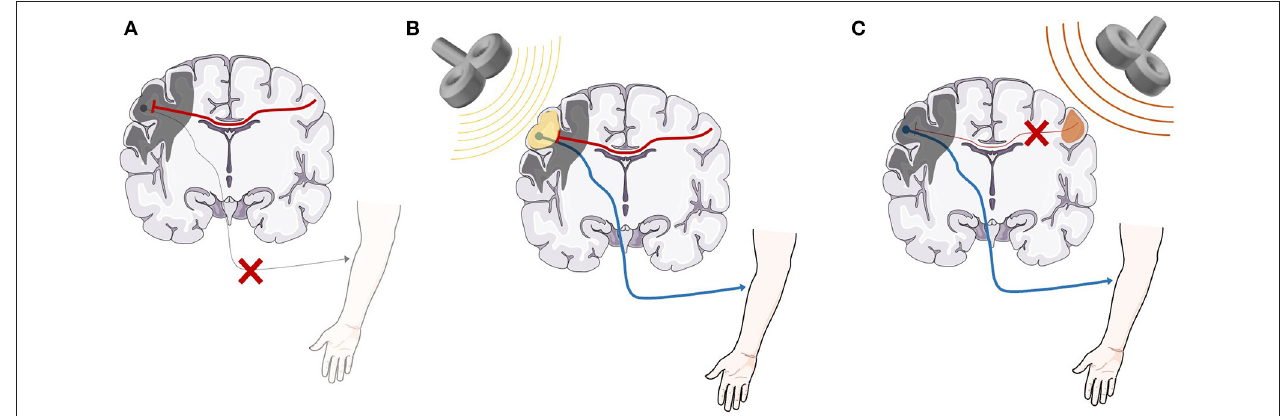
FIGURE 1 | A representation of the basic neurobiological model underlying rTMS as an adjunct treatment for stroke recovery. (A) After stroke, direct damage to the primary motor cortex as well as inhibitory signaling from the contralesional motor cortex are both likely involved in lack of functional recovery (8–11). (B) High-frequency ( > 5Hz) rTMS applied over the ipsilesional hemisphere strengthens the descending motor pathway, facilitating motor recovery. (C) Low-frequency ( < 1Hz) rTMS applied over the contralesional hemisphere reduces inhibitory signals from the contralesional motor cortex, promoting beneficial cortical reorganization and motor recovery (3). rTMS, repetitive transcranial magnetic stimulation. Anatomical images adapted from